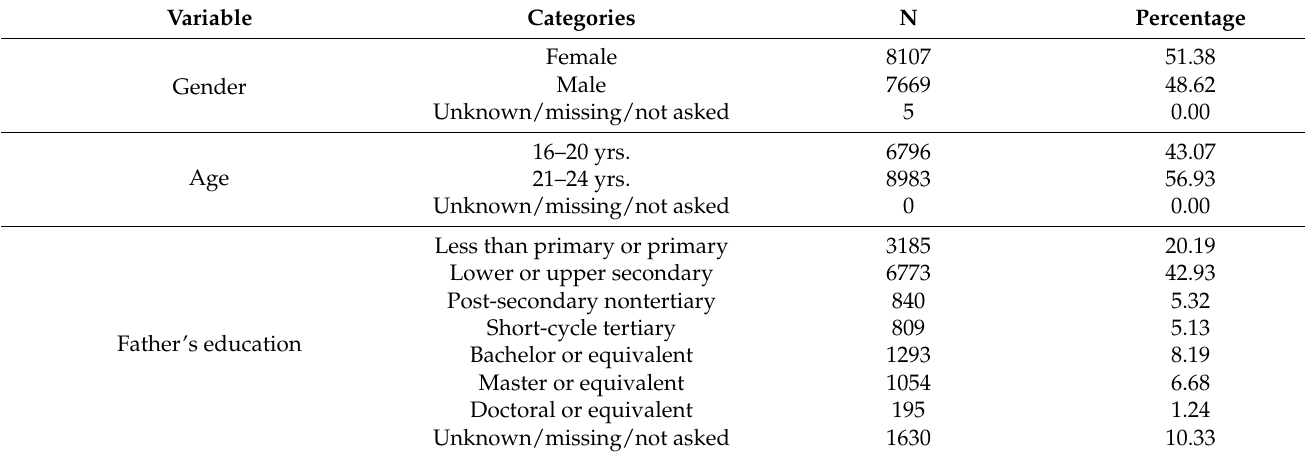
Table 1. Descriptive statistics of the study